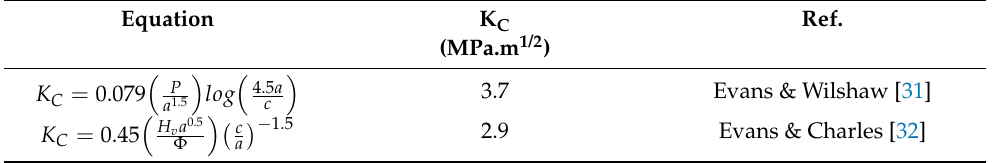
Table 4. Indentation fracture toughness of the composite with the highest microhardness.